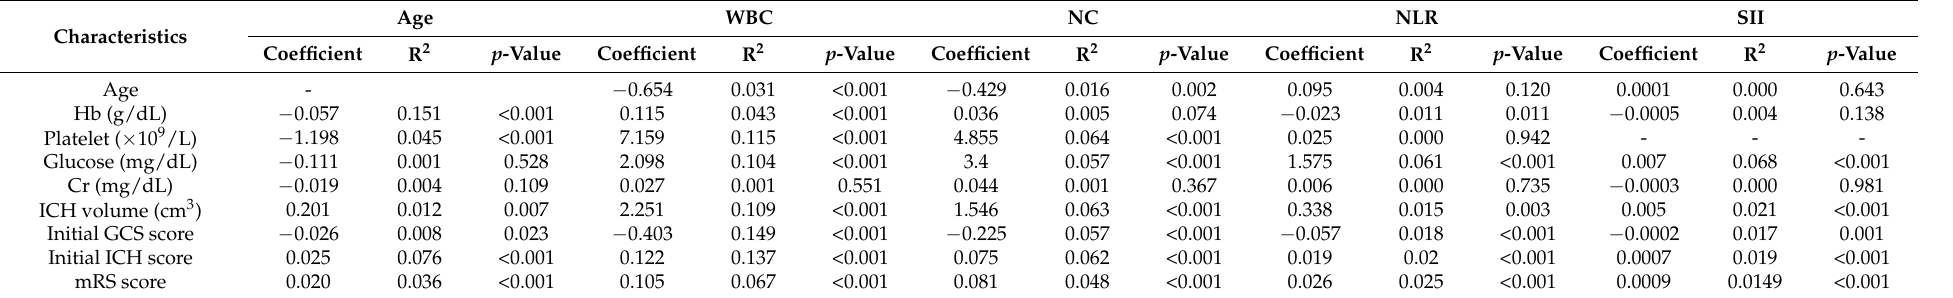
Table 3. Linear regression analyses of correlation of age and immune-inflammation markers with clinical features in 613 patients with intracerebral hemorrhage. Characteristics